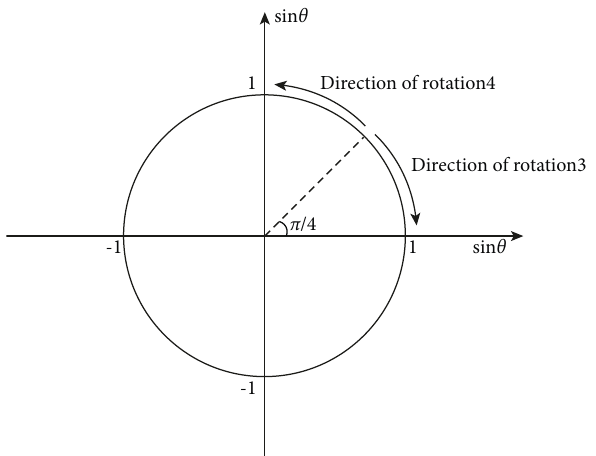
Figure 2: Direction of rotation (later stage of